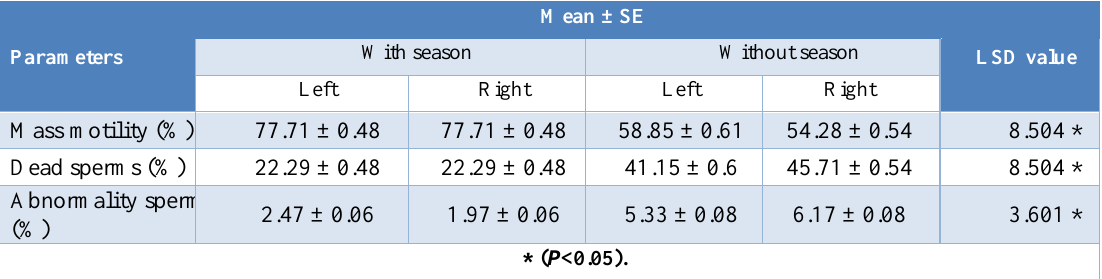
Table,3: Effect of breeding season and testicular orientation on spermatozoa mass motility %, dead spermatozoa % and spermatozoa abnormalities %.